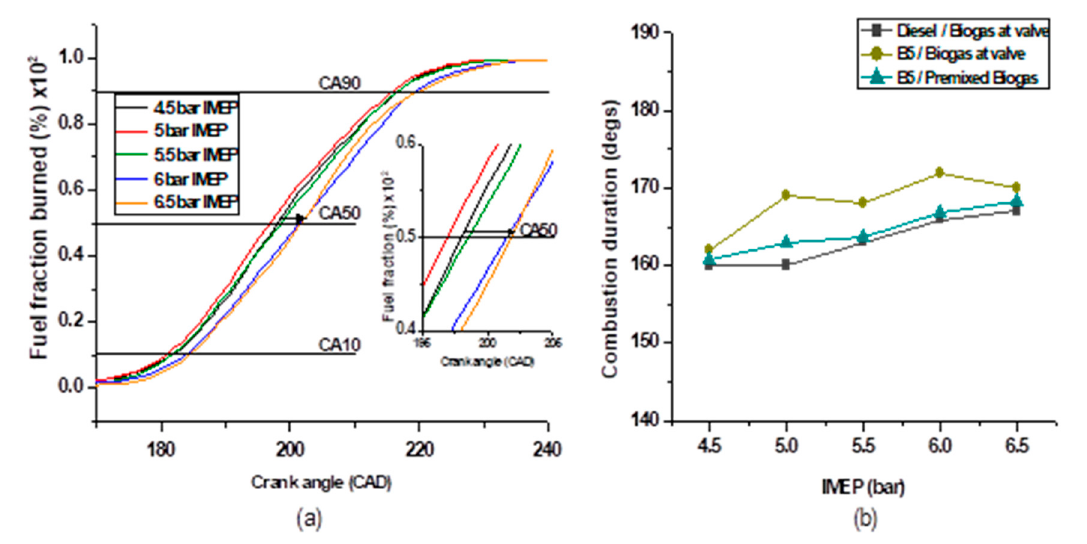
Figure 11. Variation of the ( a ) fraction burned for the B5 and biogas injected at the valve in RCCI and ( b ) combustion period of the B5 and biogas RCCI for premixed and injection at the valve in various load